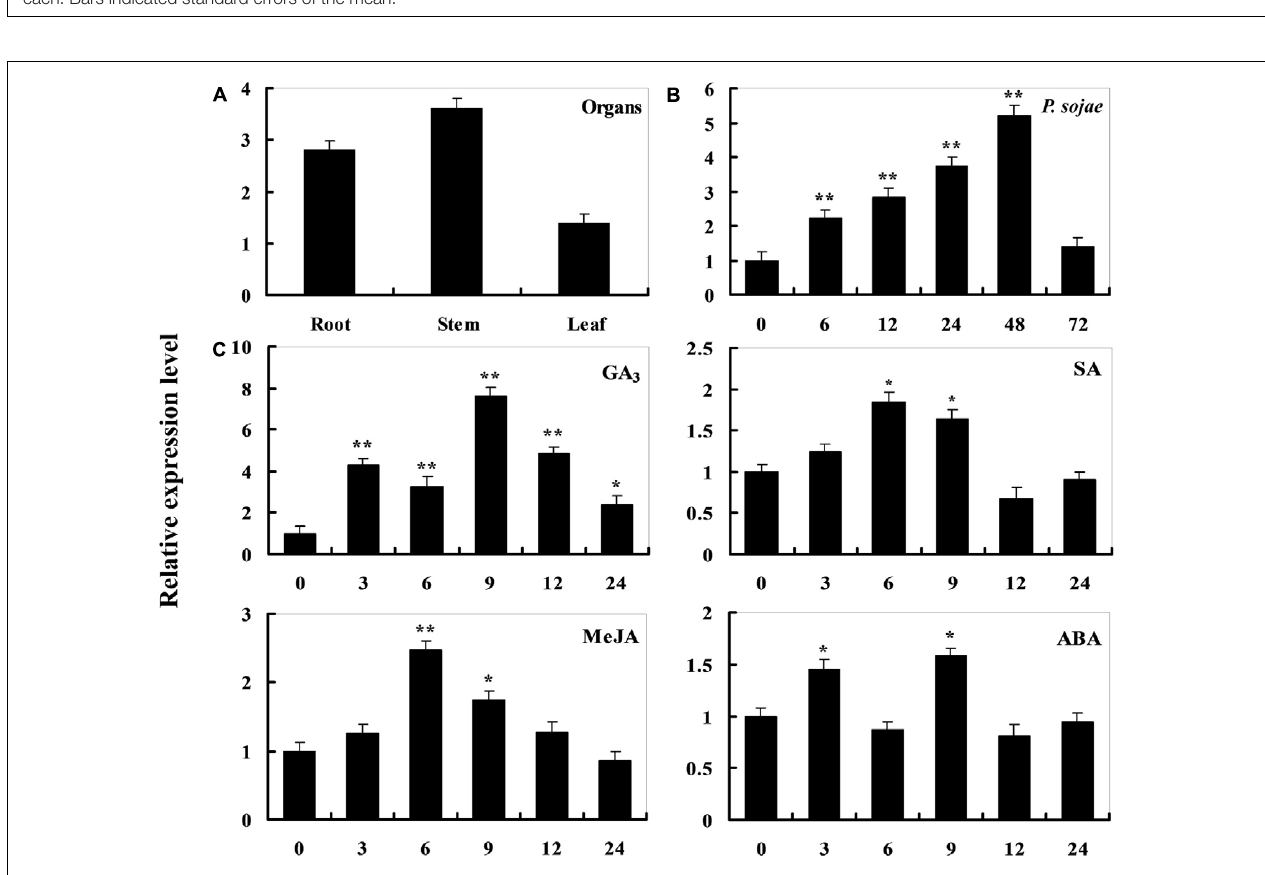
FIGURE 3 | Analysis of GmDIR22 expression patterns by qRT-PCR. (A) Roots, stems, and leaves were separated from 14-day-old seedlings. The amplification of the soybean EF1 ( GmEF1 ) gene was used as an internal control for data normalization. (B) GmDIR22 expression in soybean leaves infected with P. sojae. Soybean leaves were harvested at 0, 6, 12, 24, 36, 48, and 72 h after infection. The relative GmDIR22 transcript levels were quantified and compared between infected and mock-treated control plants at the same time point. (C) GmDIR22 expression in soybean leaves in response to exogenous hormone: SA (0.5 mM), MeJA (100 µ M), ABA (50 mM), and GA 3 (50 mg.L − 1 ) treatment for 0, 3, 6, 9, 12, and 24 h. The soybean Actin ( GmActin4 ) gene was used as an internal control for data normalization. Experiments were performed using three biological replicates with three technical replicates each, and statistically analyzed using Student’s t -tests ( ∗ P < 0.05, ∗∗ P < 0.01). Bars indicated standard errors of the mean.